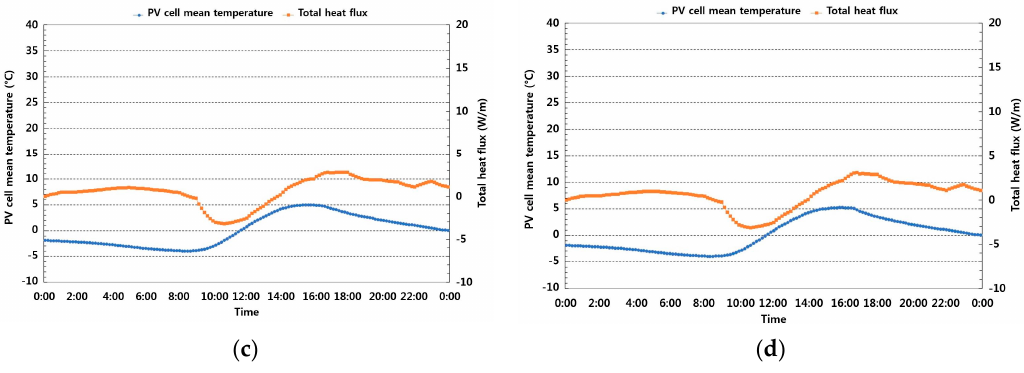
Figure 9. Comparison of mean operating temperatures of PV cell and total heat flux from panel to surrounding under the cloudy sky and cold temperature (winter season): ( a ) Case1; ( b ) Case2 PCM1; ( c ) Case2 PCM2; and ( d ) Case3 PCM2.